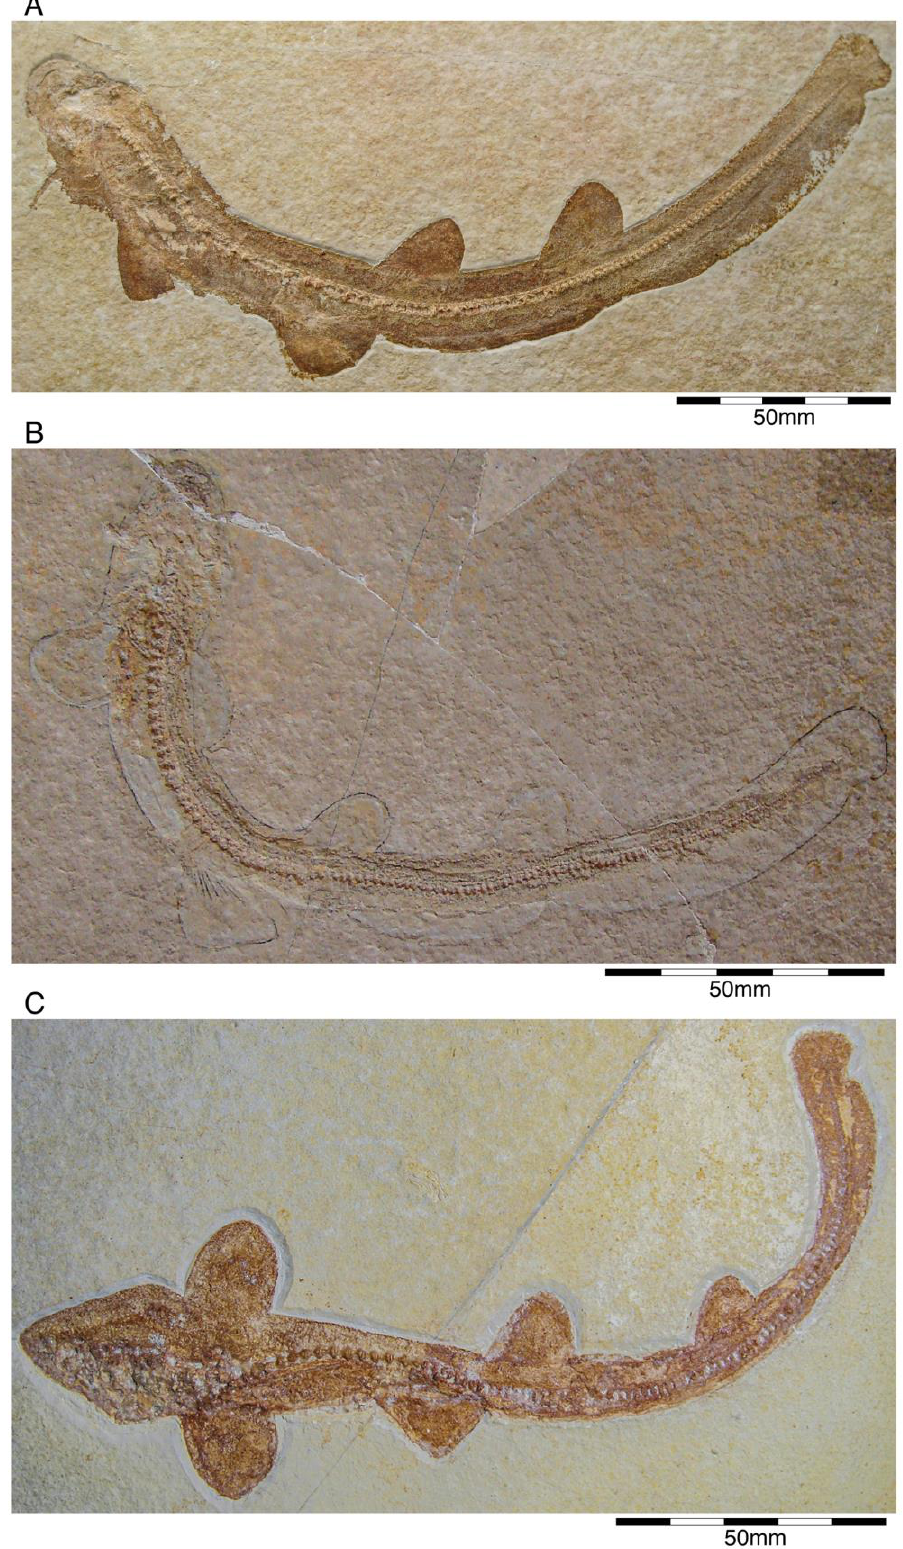
Figure 23. † Bavariscyllium tischlingeri Thies, 2005 [55] ( A ) Holotype specimen (JME SOS 4124) from the lower Tithonian of Eichstätt. ( B ) Holomorphic specimen (SMF P272) from the lower Tithonian of Eichstätt. ( C ) Holomorphic specimen (SMNS 96086) from the lower Tithonian of Eichstätt. Genus † Palaeoscyllium Wagner, 1857 [102]